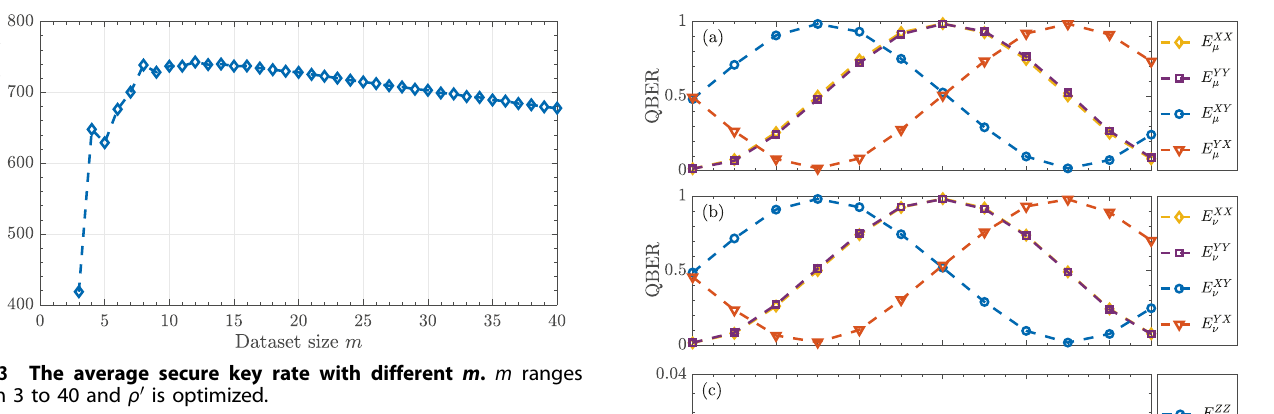
Table 1. Secure key rate calculated with different fi nite length when m and ρ 0 are both optimized.